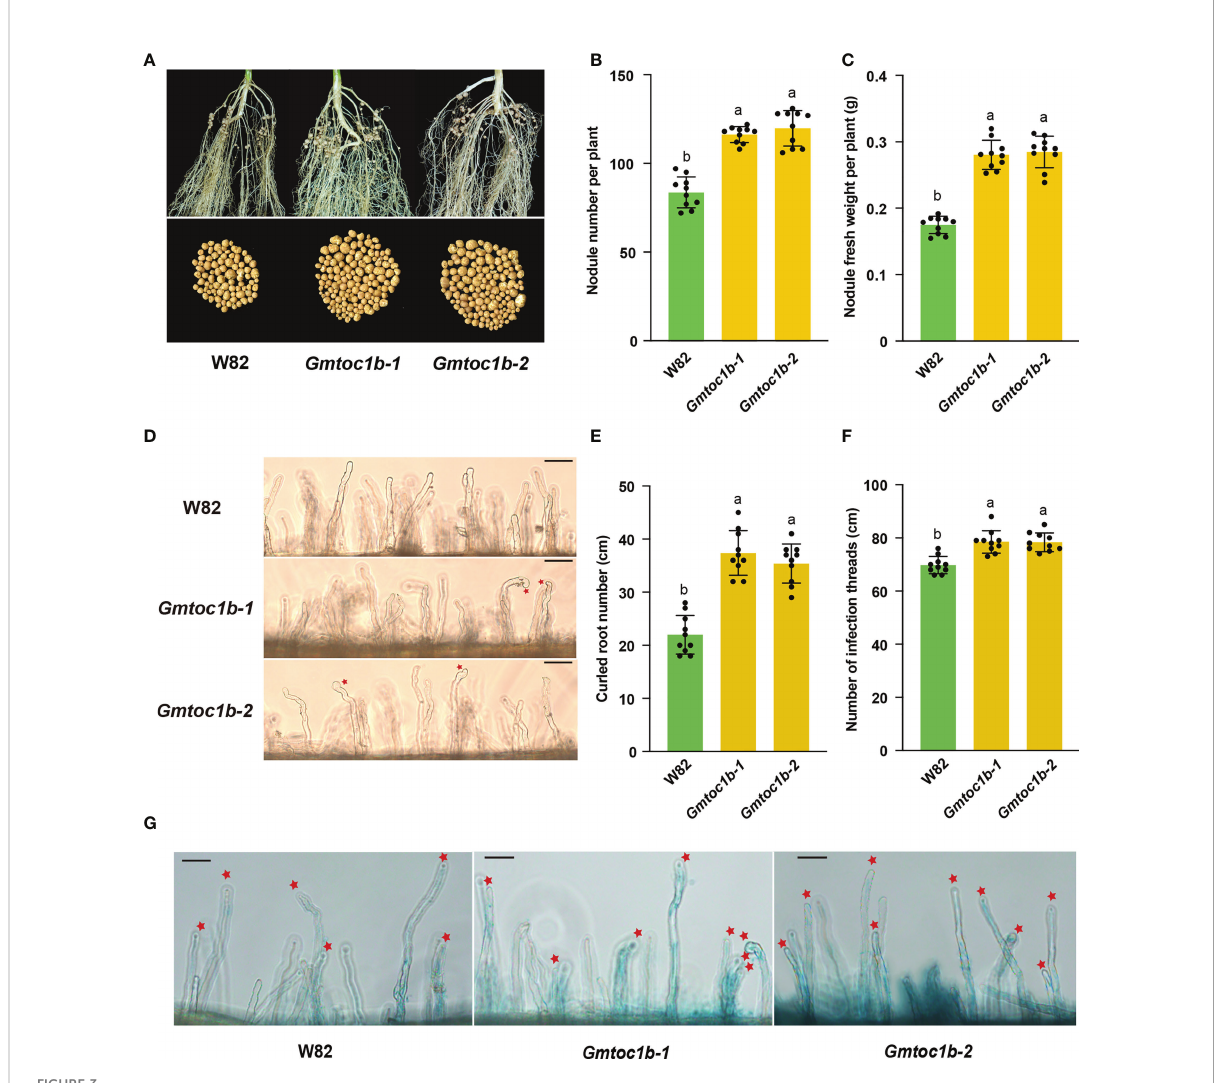
FIGURE 3 Knockout of GmTOC1b promotes nodulation in soybean. (A) Representative nodule performance of W82 and Gmtoc1b mutants at 14 DAI. (B, C) Nodule number and nodule fresh weight per plant for W82 and Gmtoc1b mutants at 14 DAI. Values are the mean ± SD. (D) Representative image of root hair curling in W82 and the Gmtoc1b mutant at 3 DAI. Scale bar, 100 m m. (E) Number of curled root hairs on W82 and Gmtoc1b mutant plants per centimeter of root length (n = 10). (F) Number of infection threads in W82 and Gmtoc1b mutants per centimeter of root length (n = 10). (G) Representative image of infection numbers observed in the W82 and Gmtoc1b mutants at 5 DAI (n = 10). Scale bars, 100 m m. Different lowercase letters indicate signi fi cant differences as determined by Student ’ s t